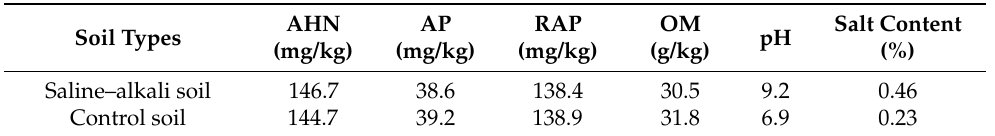
Table 1. Basic nutrient status of soil (AHN: alkali-hydro nitrogen; AP: available phosphorus; RAP: rapidly available potassium; OM: organic matter).